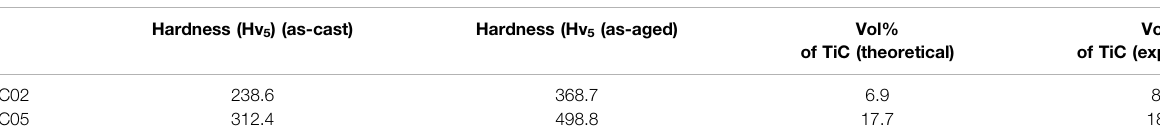
TABLE 3 | Hardness and vol% of TiC of both alloys.